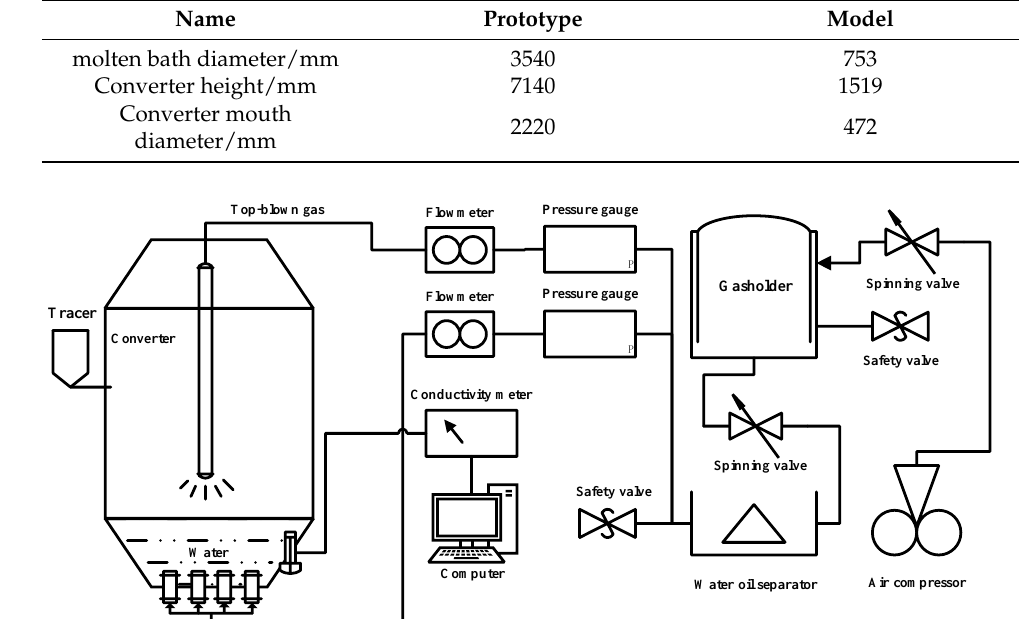
Table 1. Comparison of main dimensions of converter prototype and model.